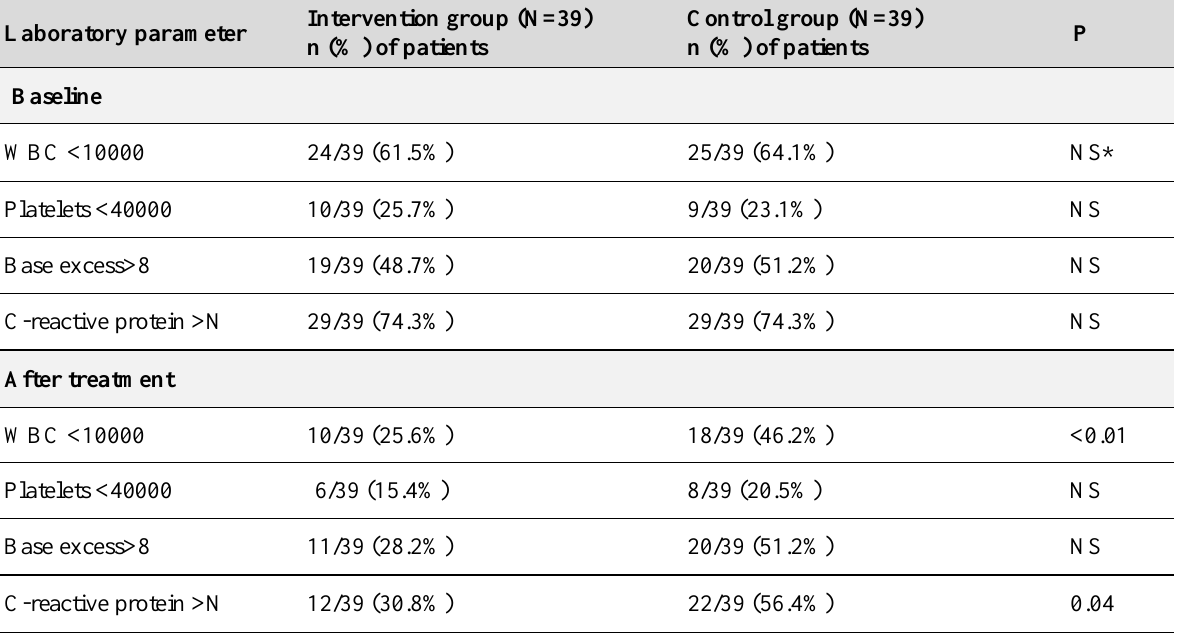
Table 2. Patients with abnormal laboratory values before and after treatment Laboratory